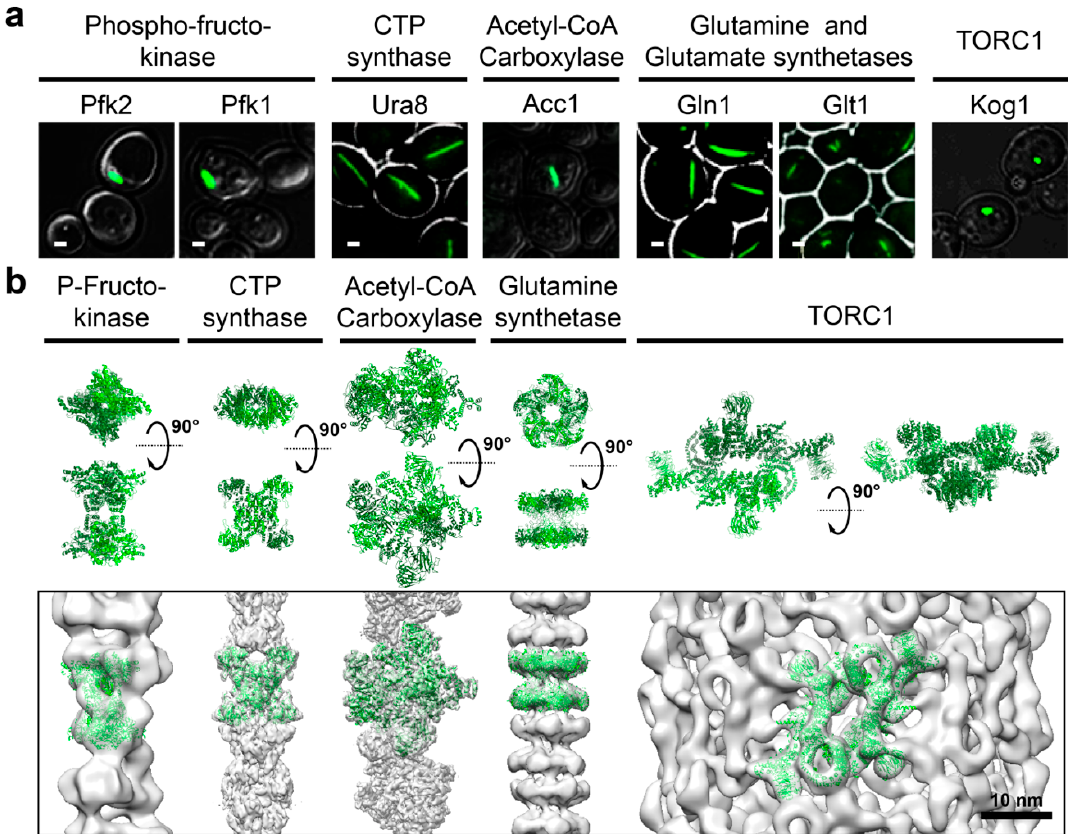
Figure 2. Metabolism related enzymes form polymers in various organisms. ( a ) Examples of metabolic enzymes observed to coalesce into cytosolic condensates. Adapted from Shen et al. (2016) [19] and Petrovska et al. (2014) [38]. ( b ) Structures of metabolic enzymes that polymerize into filaments. The protomer of the polymer is shown above, and placed into the filament below. From the Protein Data Bank: Model of P-Fructo-Kinase PDB ID 4XYJ [61], model of cytidine triphosphate (CTP) synthase PDB ID 5U03 [51], model of Acetyl-CoA 6G2D [33], model of Glutamine synthetase PDB ID 3FKY [53], model of mTORC1 PBD ID 5FLC [62]. From the Electron Microscopy Data Bank: Negative stain electron microscopy (EM) map of P-Fructo-Kinase filament emd-8542 [21], cryo-EM map of the human CTP synthase filament emd-8474 [51], cryo-EM map of human Acetyl-CoA with citrate emd-4342 [33], model of cryo-EM map filtered at 20 Ang of the yeast Glutamine synthetase filament based on the dodecameric oligomer [53], cryo-EM map of TOROID emd-3814 [16].